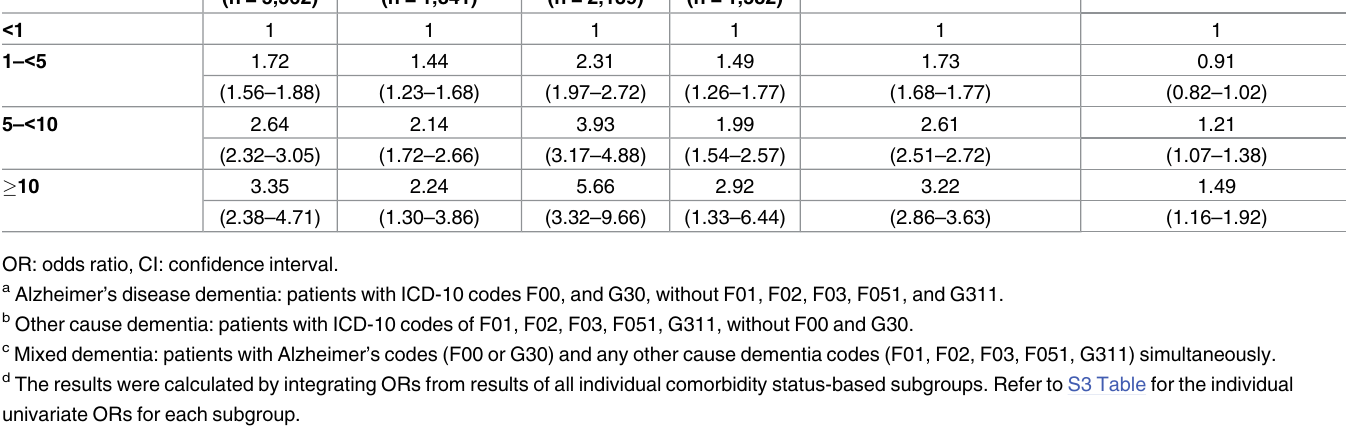
Table 3. Univariate logistic regression analysis for polypharmacyand dementia segregated by patient subgroups. Average number of prescribed daily